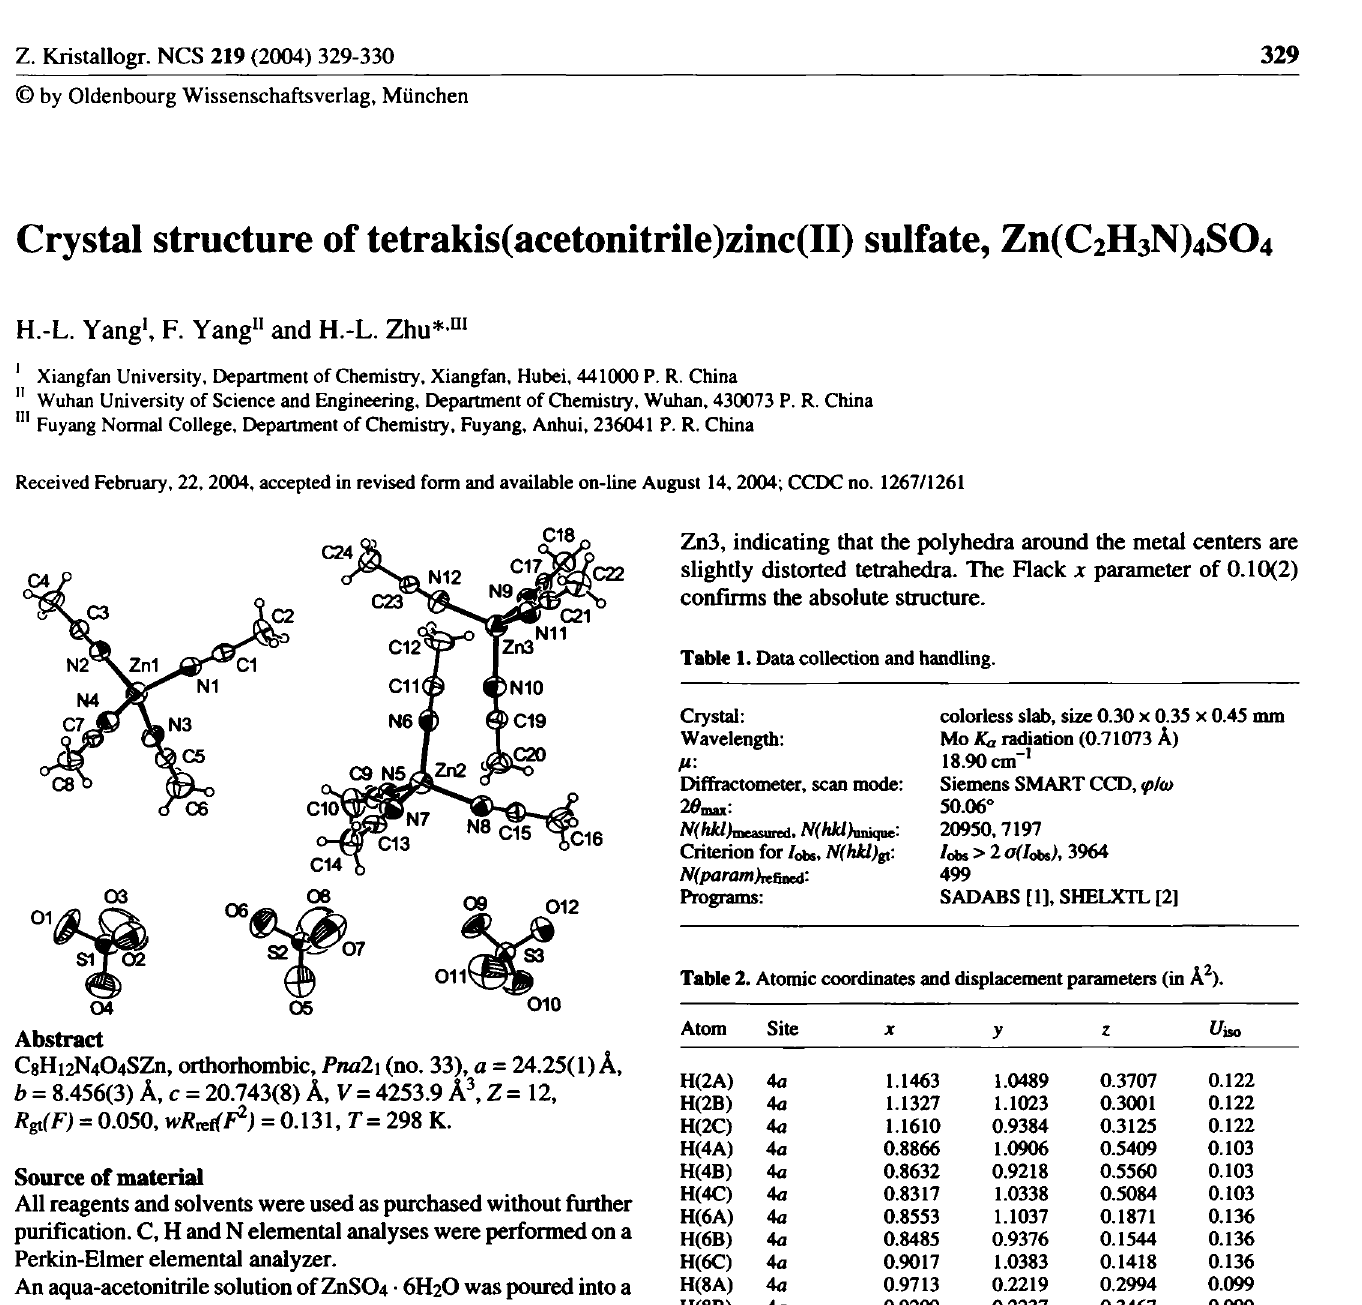
Table 2. Atomic coordinates and displacement parameters (in A 2